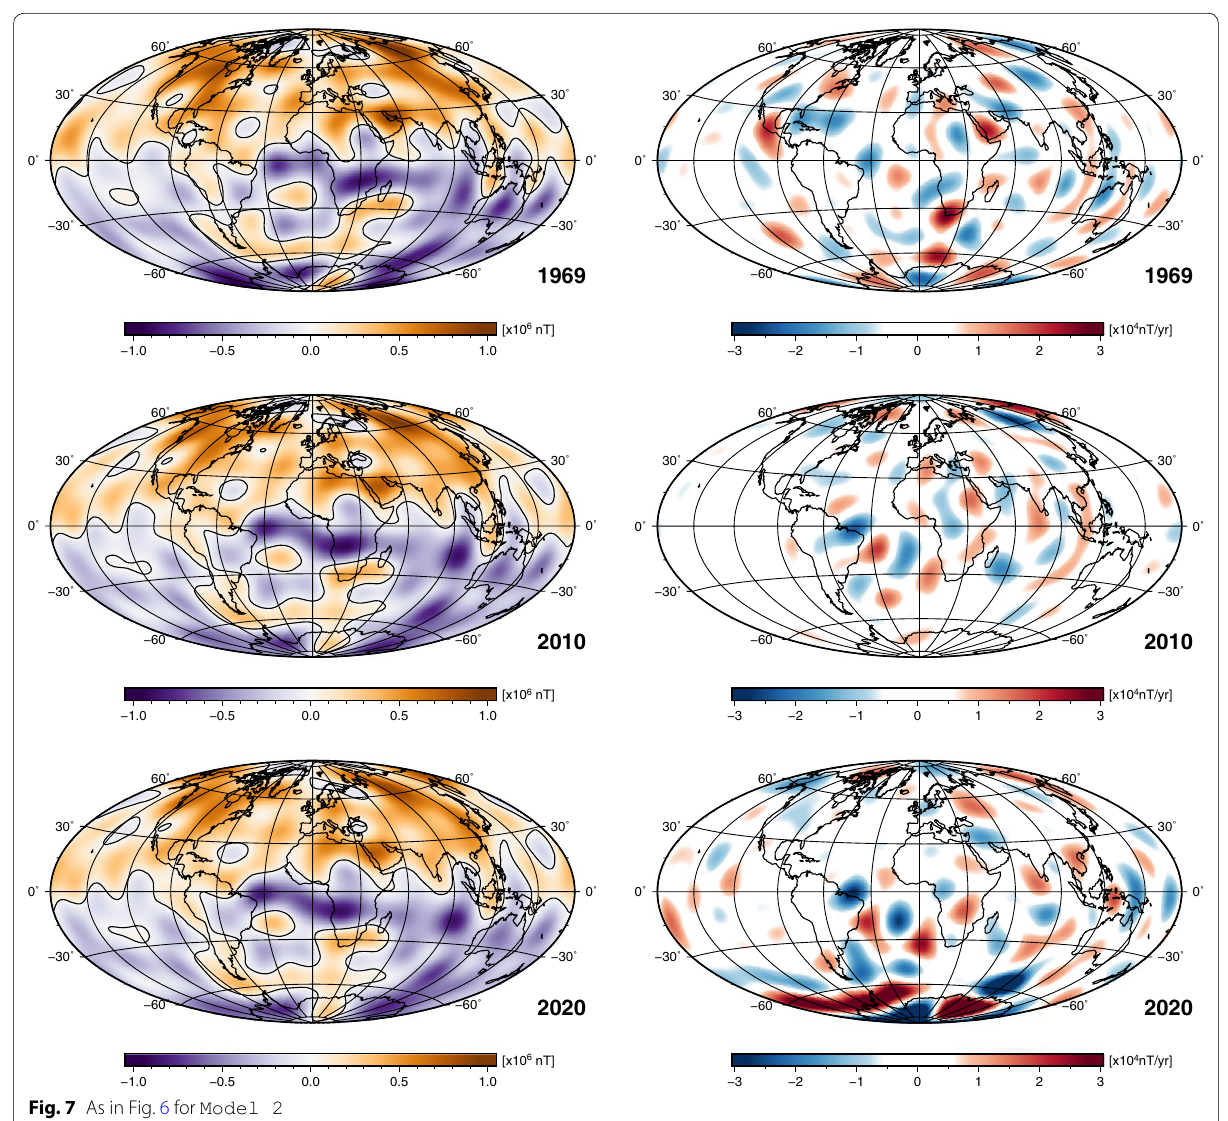
Fig. 7 As in Fig. 6 for Model